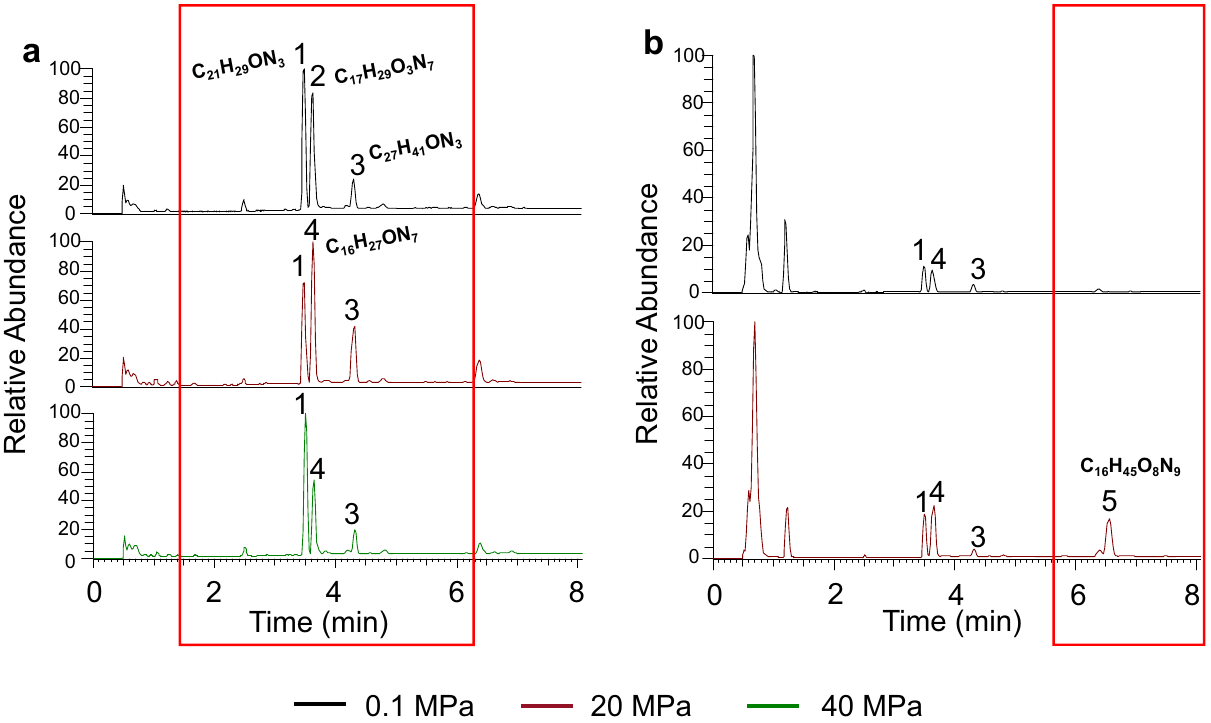
Figure 5. TIC diagrams of metabolites of hadal-derived fungi isolated and cultured under three preset hydrostatic pressures. ( a ) TIC peak of Cladosporium sp. CIEL 2 at different hydrostatic pressures. In addition to the change of peak intensity, 4 but not 2 appeared in the metabolites at 20 MPa and 40 MPa. ( b ) TIC peak of Stemphylium vesicarium CIEL 5 at different hydrostatic pressures. A new peak 5 appears at 20 MPa. Each analysis shows the extracted ion track of the corresponding compounds recorded by mass spectrometry. The relative abundance was set at